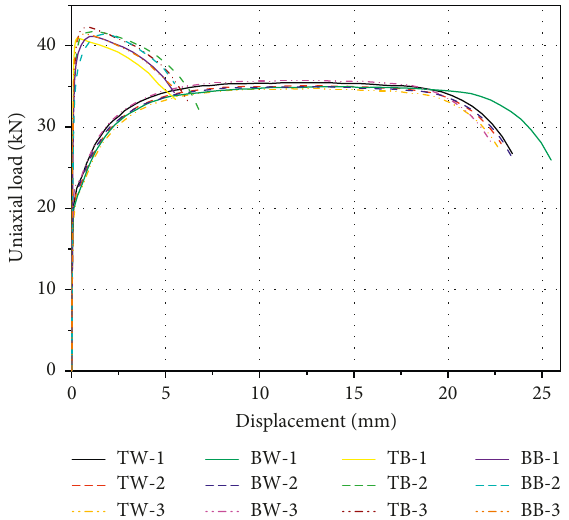
Figure 7: Load-displacement curves of flat and corner coupons.